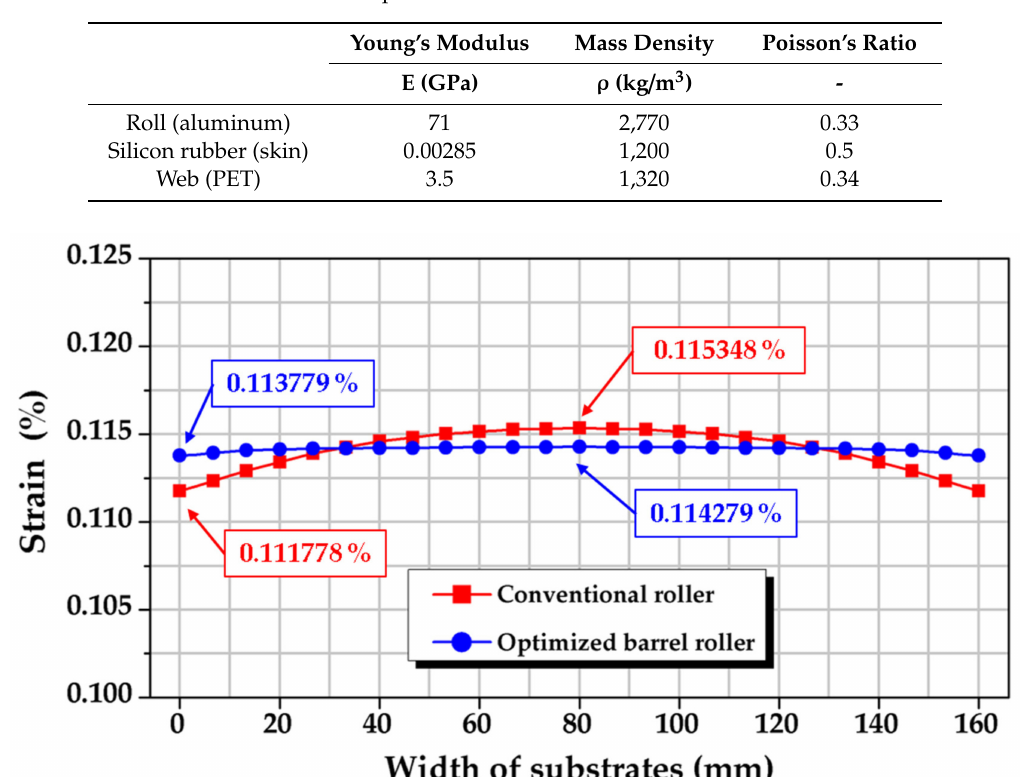
Table 9. Mechanical properties applied to FEA to simulate the MD strain deviation of the web under the same tension conditions as the experiment.